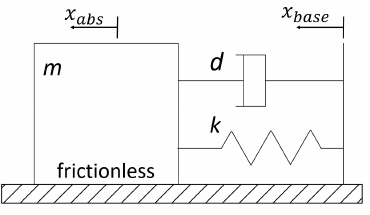
Figure 13. Model of the oscillator.